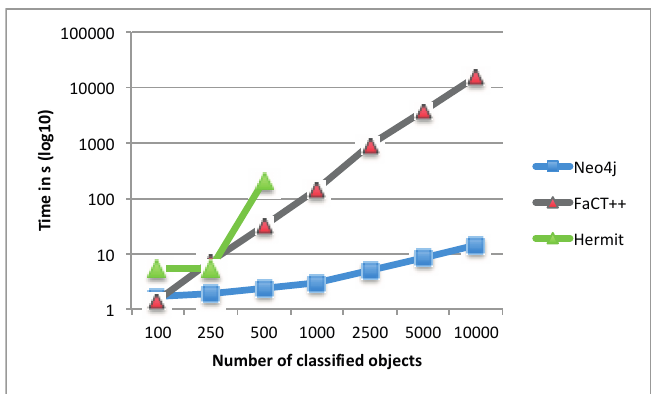
Figure 9. Classification time for each reasoner tested in Protégé vs. Neo4j.